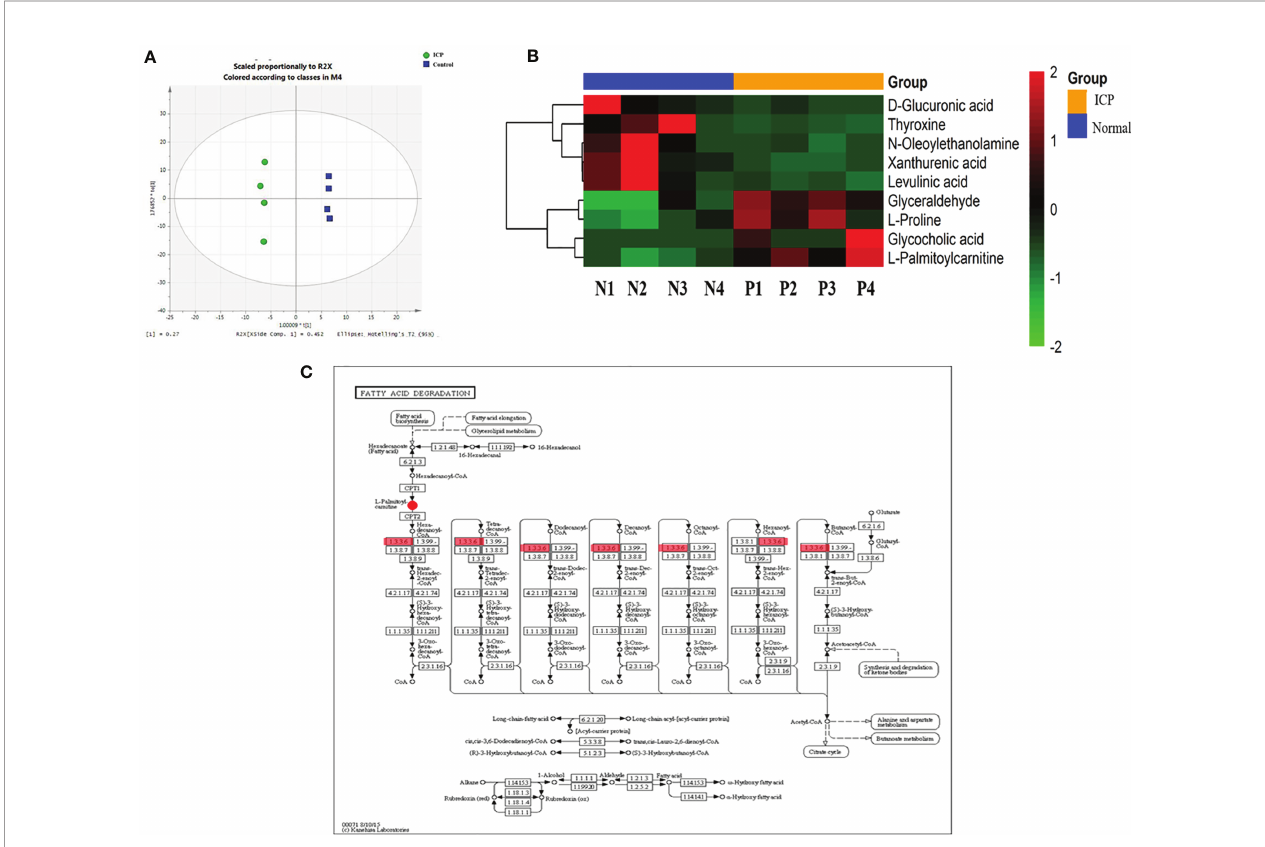
FIGURE 1 | Integrated proteomics and metabolomics analysis. (A) OPLS-DA score plots derived from analysis of placental tissue by ultra-performance LC-Q-TOF/ MS in positive and negative ionization modes. R 2 X and R 2 Y indicate the fraction of the variables explained by the model, while Q 2 shows the predictive abilities of the model. R 2 X = 0.452, R 2 Y = 0.998, and Q 2 = 0.803. The green circle is labeled as ICP; the blue square is labeled as control; (B) Cluster analyses of differentially expressed placental metabolites among pregnant women with ICP (P) and healthy pregnant women (N). Hierarchical cluster analyses of the nine differentially expressed metabolites revealed signi fi cantly altered levels in ICP patients. Metabolite levels are shown as colored boxes; red, high level; green, low level; (C) Part of the fatty acid metabolism pathway. The 1.3.3.6 are labeled as ACOX1. ACOX1 maintains a regulatory relationship with